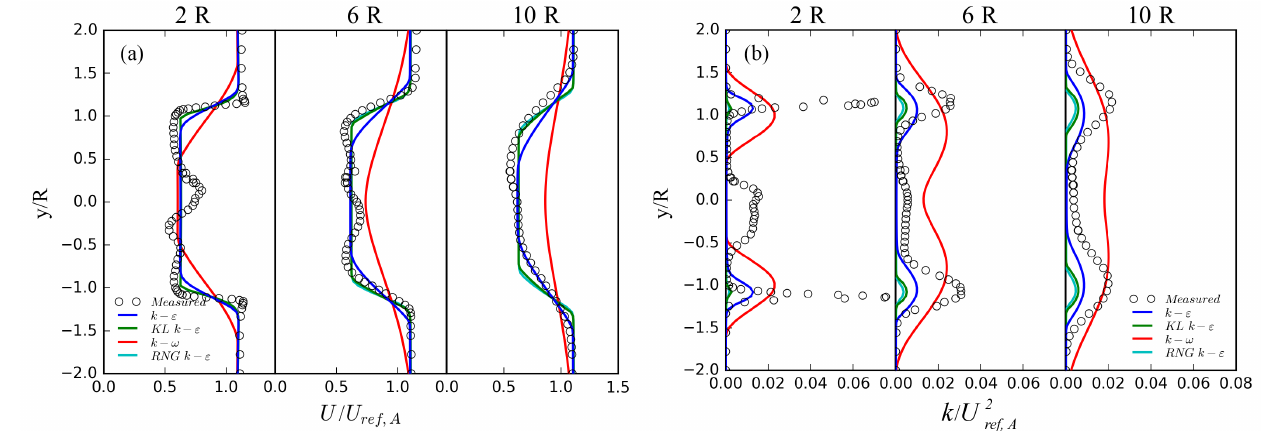
Figure 6. (a) Normalized axial velocity and (b) normalized turbulence kinetic energy computed behind a single model wind turbine (case A) at x/R = 2, 6 and 10 for different turbulence models using the uniform distribution.